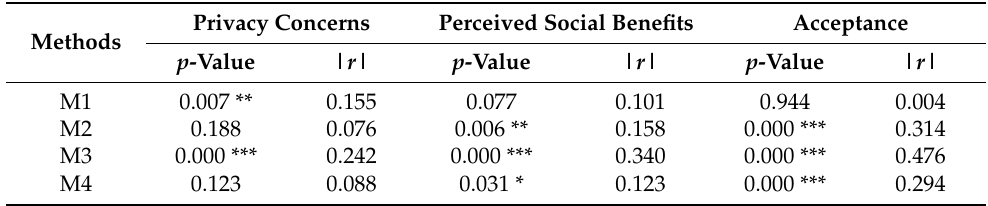
Table 4. Mann–Whitney test results for the four contact tracing methods (comparison between the U.S. and South Korea).